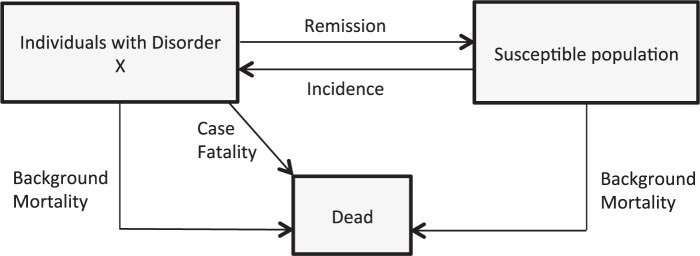
Model explanation.